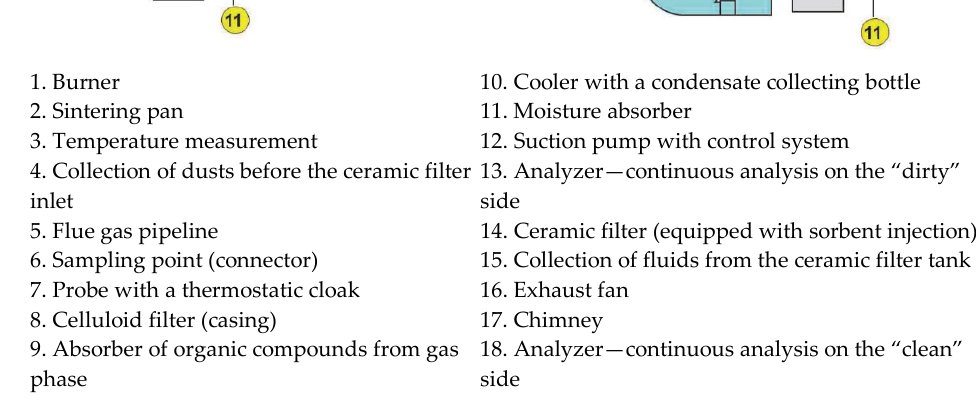
oxide (MgO) content—1.3 wt.%.